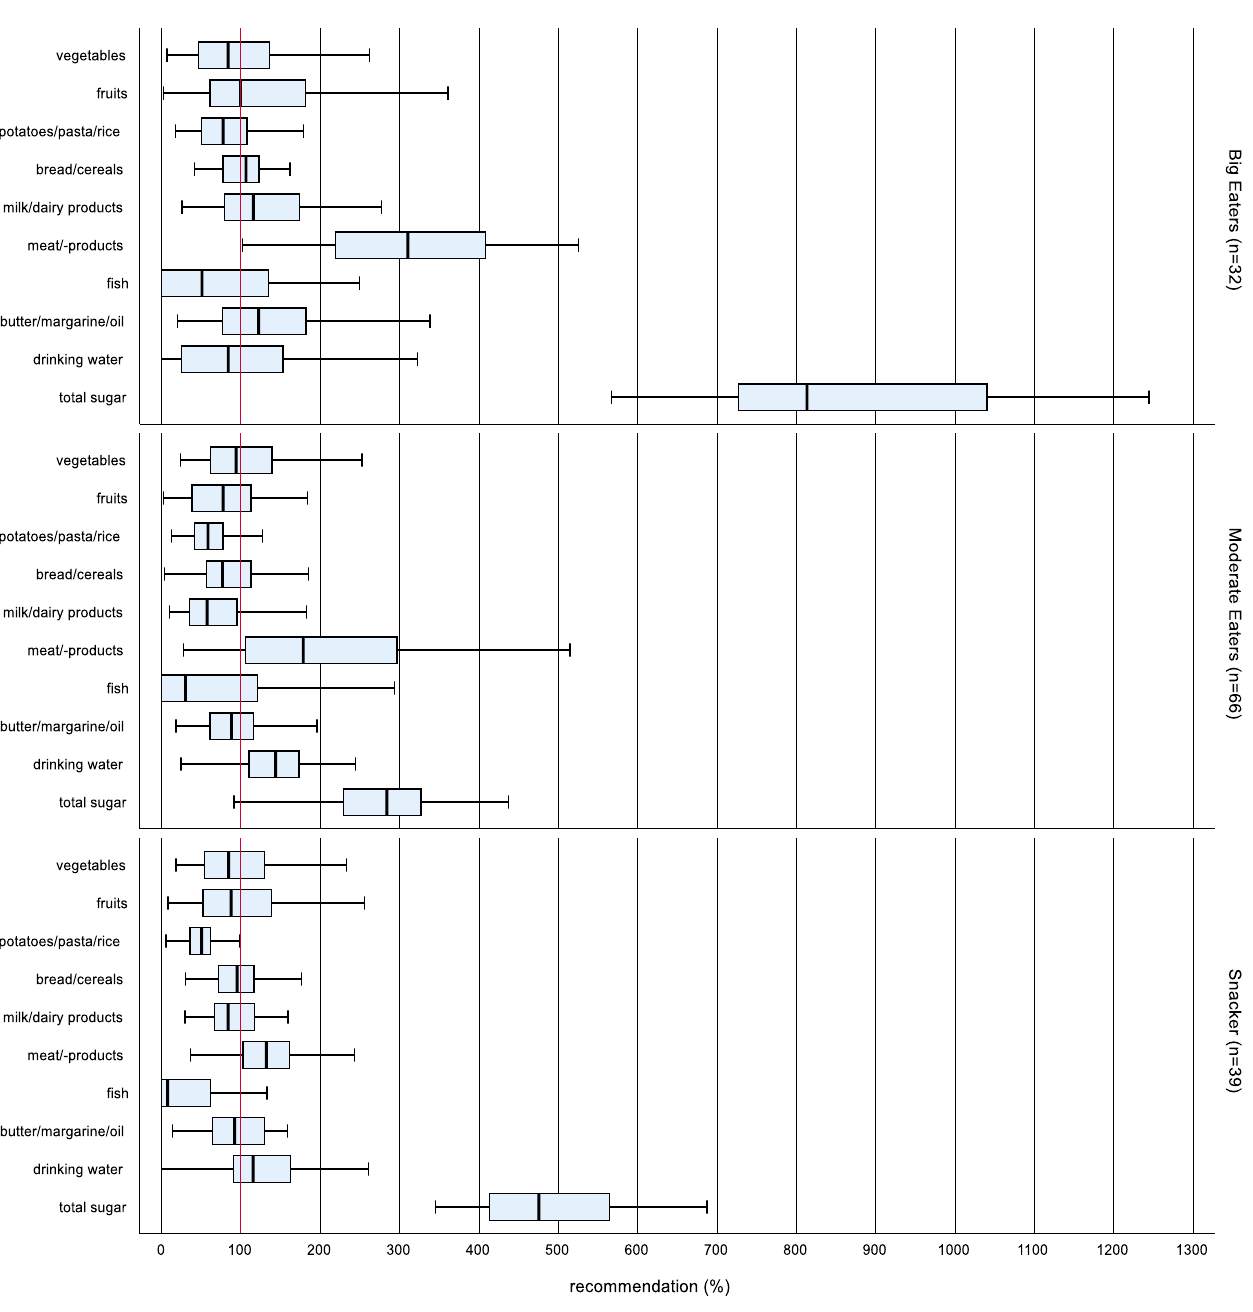
Figure 2. Box-Whisker plots * of the intake in proportion to the OMD recommended amount according to dietary patterns at enrollment (n = 137). * Box-Whisker plots with the inner box corresponding to the interquartile range around the median and the whisker corresponding to the 5th and 95th percentiles (pct).